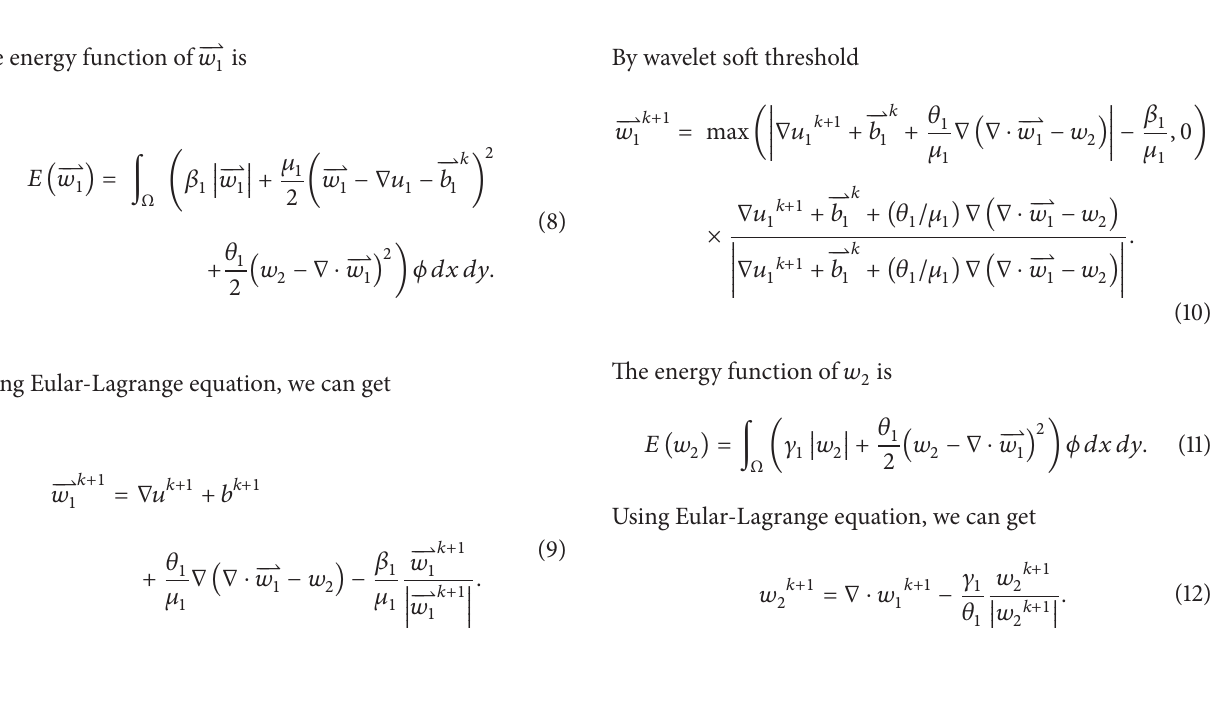
Figure 2: Image for segmentation. (a) Original image. (b) Result using CV model. (c) Result using mean shift method. (d) Segmentation result using proposed